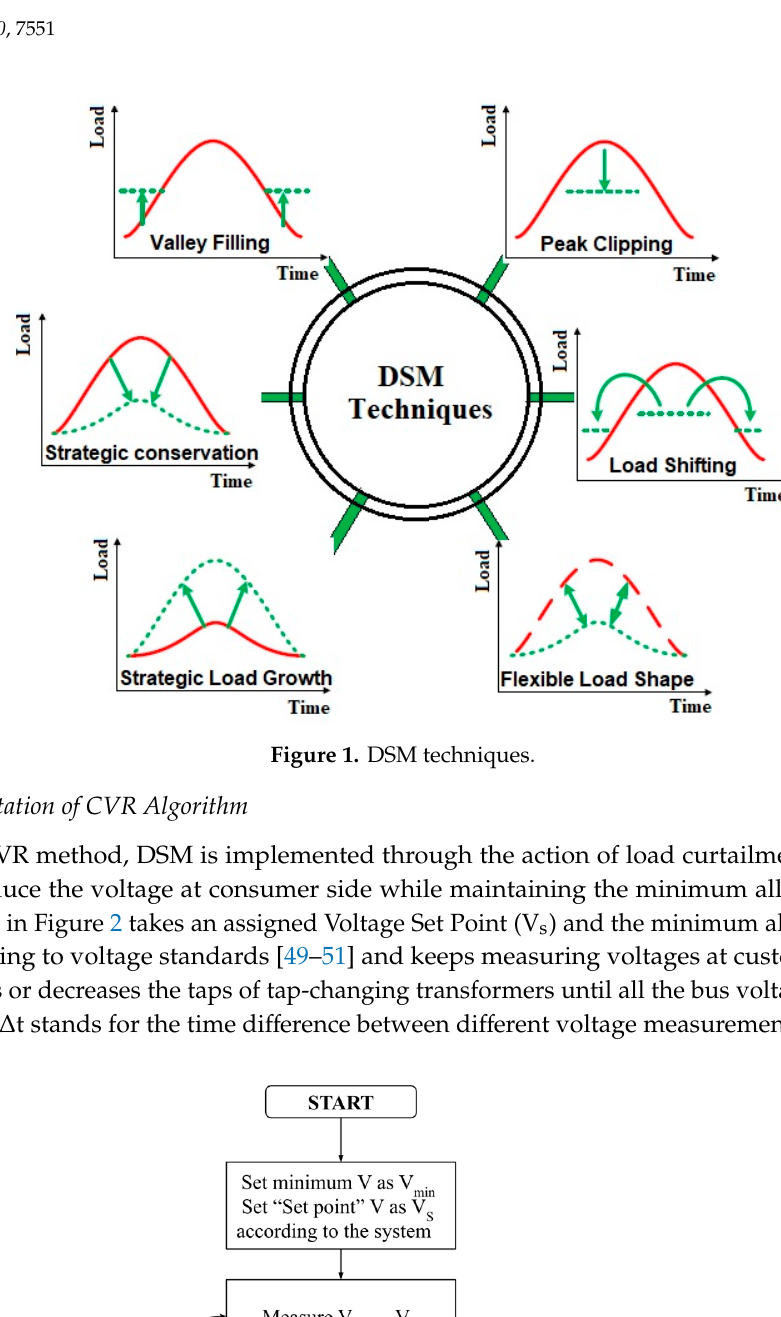
Figure 2. CVR algorithm flowchart.